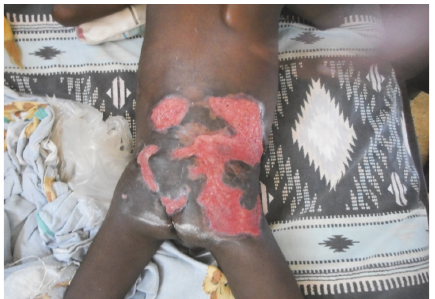
Figure 1: Basidiobolomycosis with ulcers in the